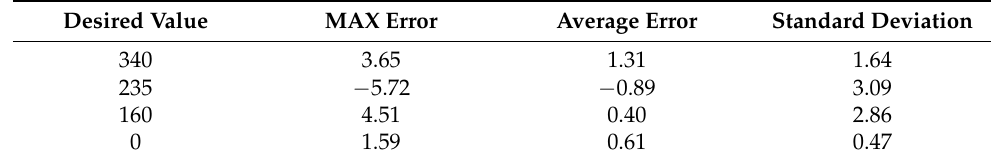
Table 4. Error analysis of heading